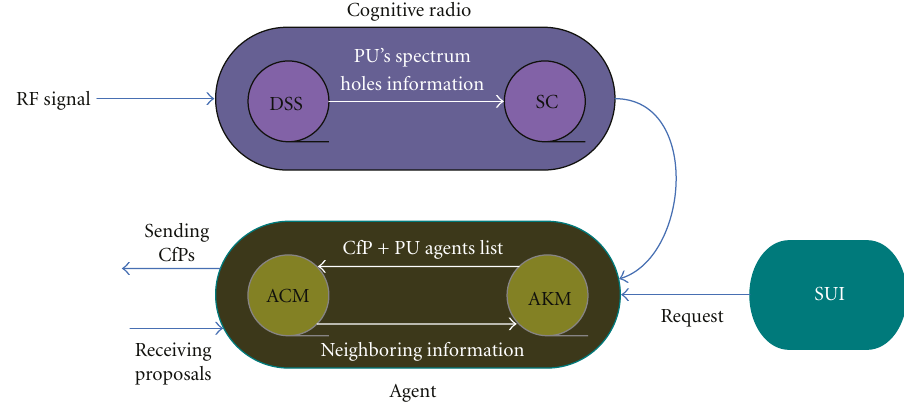
Figure 2: Various functioning modules for primary and secondary